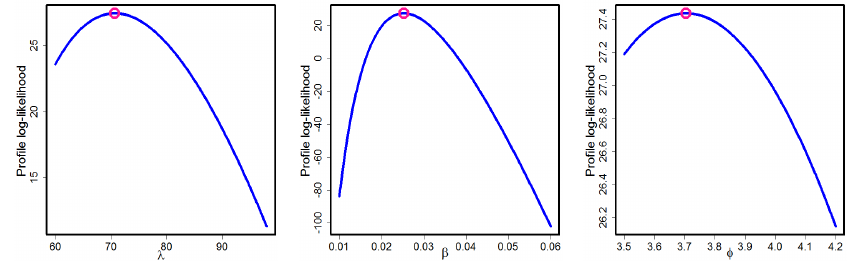
Fig. 16: Uni-modal pro(cid:133)le likelihood functions of parameters of HLUG-TI for Data II. Figure 16. Unimodal profile likelihood functions of parameters of HLUG-TI for Data